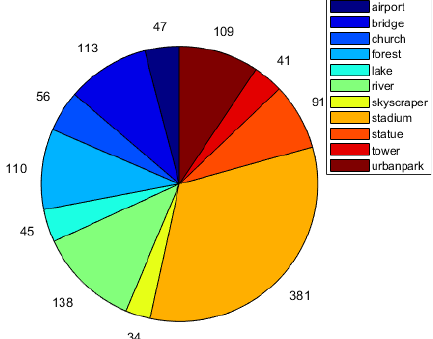
Figure 3. Class distribution of